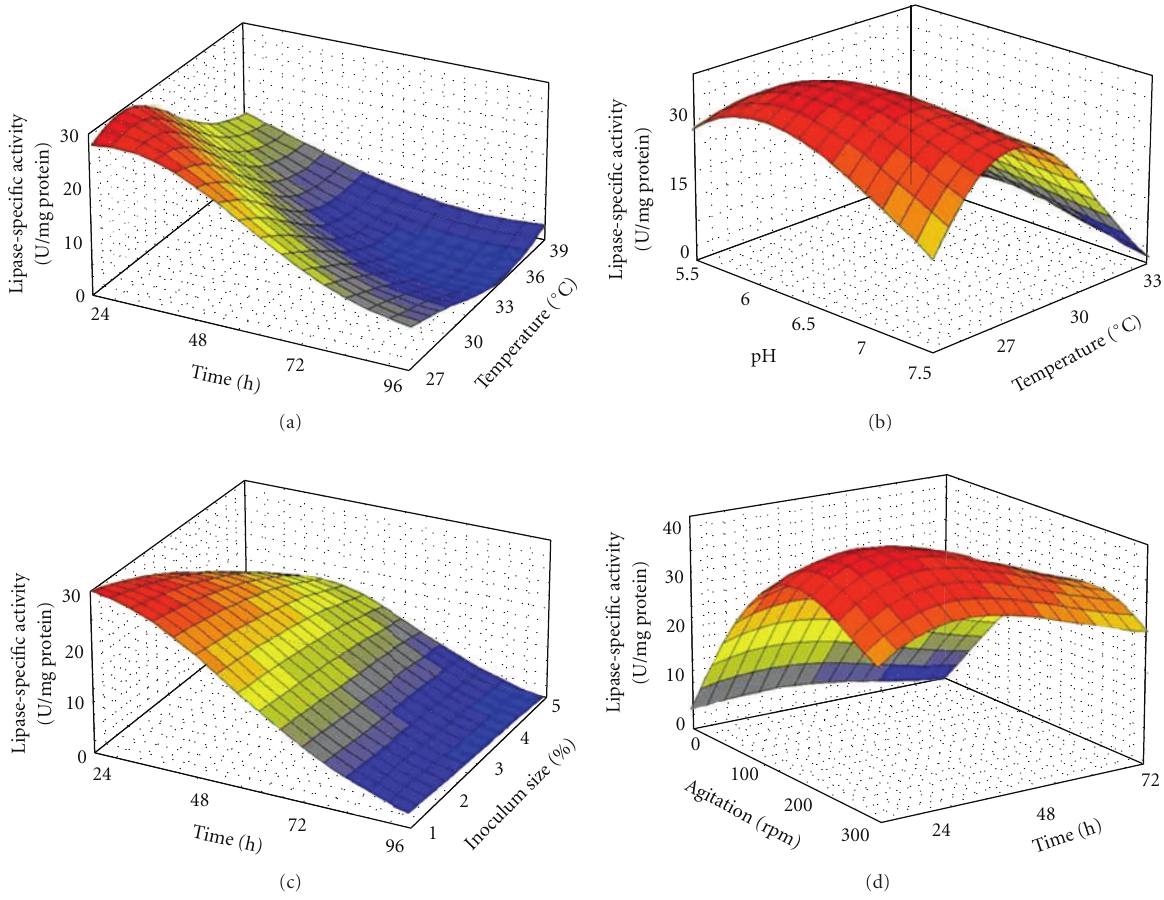
Figure 1: Three dimensional plots for the interaction e ff ect of: (a) time and temperature; (b) pH and temperature; (c) time and inoculum size; (d) agitation and time on Acinetobacter sp. lipase production in SmF. The colors from blue to gray, green, yellow, orange, and red, respectively, show increasing the lipase-specific